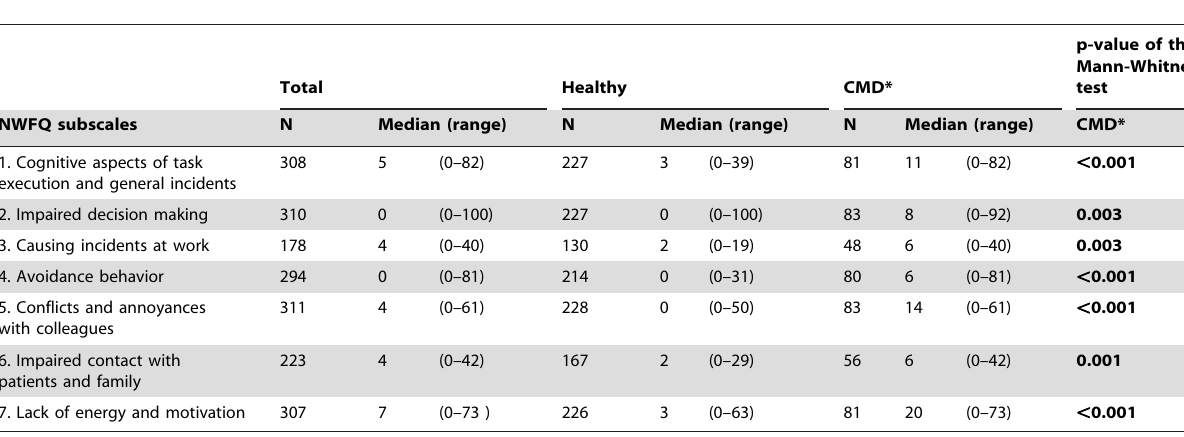
Table 4. Discriminative validity using a Mann-Whitney-U test with the T1